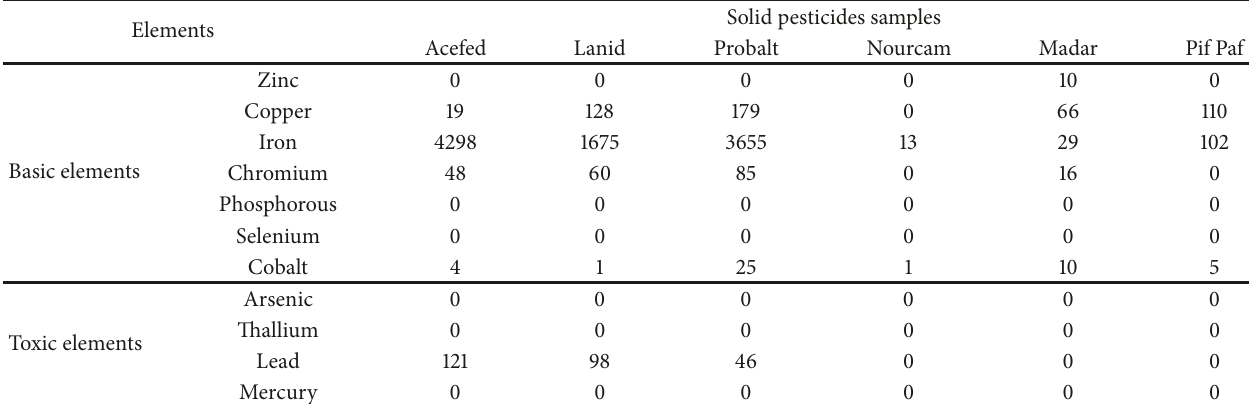
Figure 1: Proportions of the studied elements in the liquid insecticides samples. Table 2: The percentage (ppb) elements in the solid insecticides